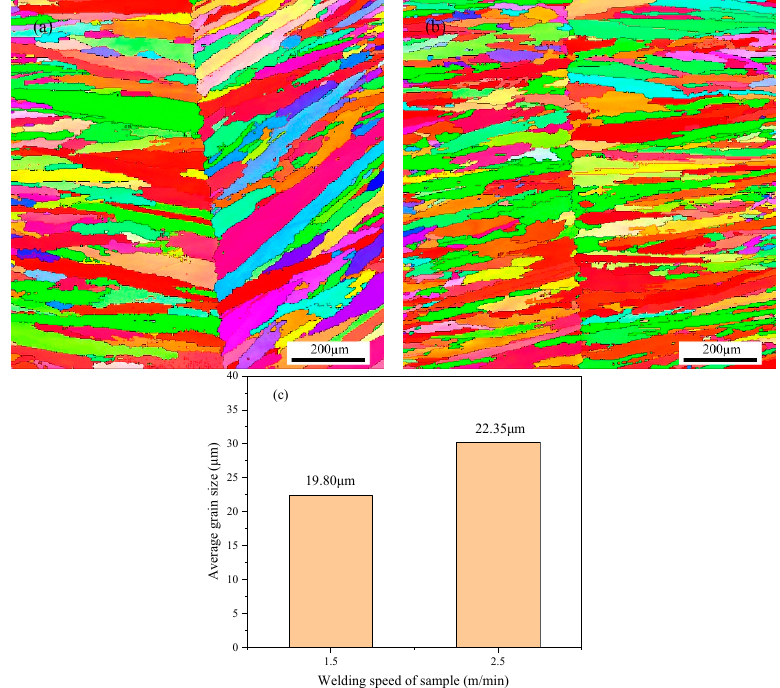
Figure 7. The inverse pole figures (IPF) of FZ under the welding speed of ( a ) 1.5 m/min and ( b ) 2.5 m/min; and ( c ) average grain size of samples.